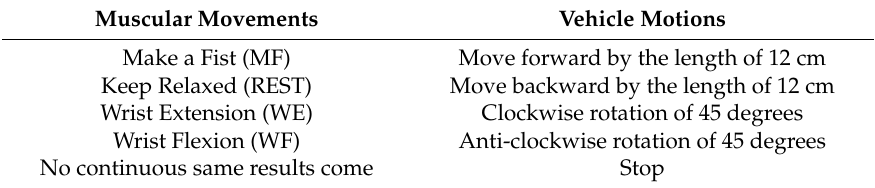
Table 2. Definition of muscular movements and corresponding commands to